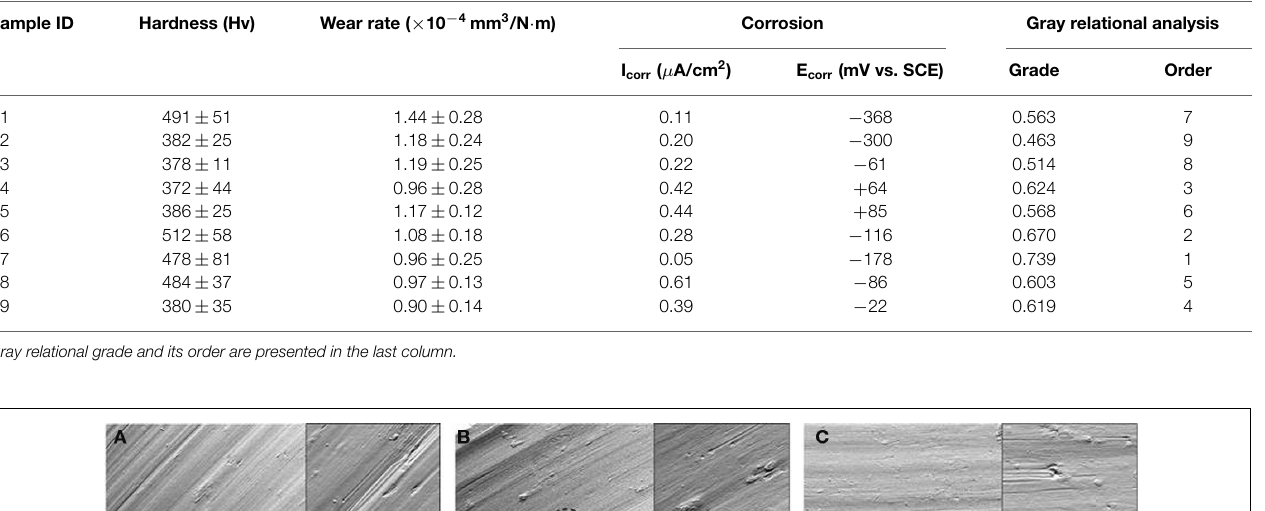
Frontiers in Mechanical Engineering |